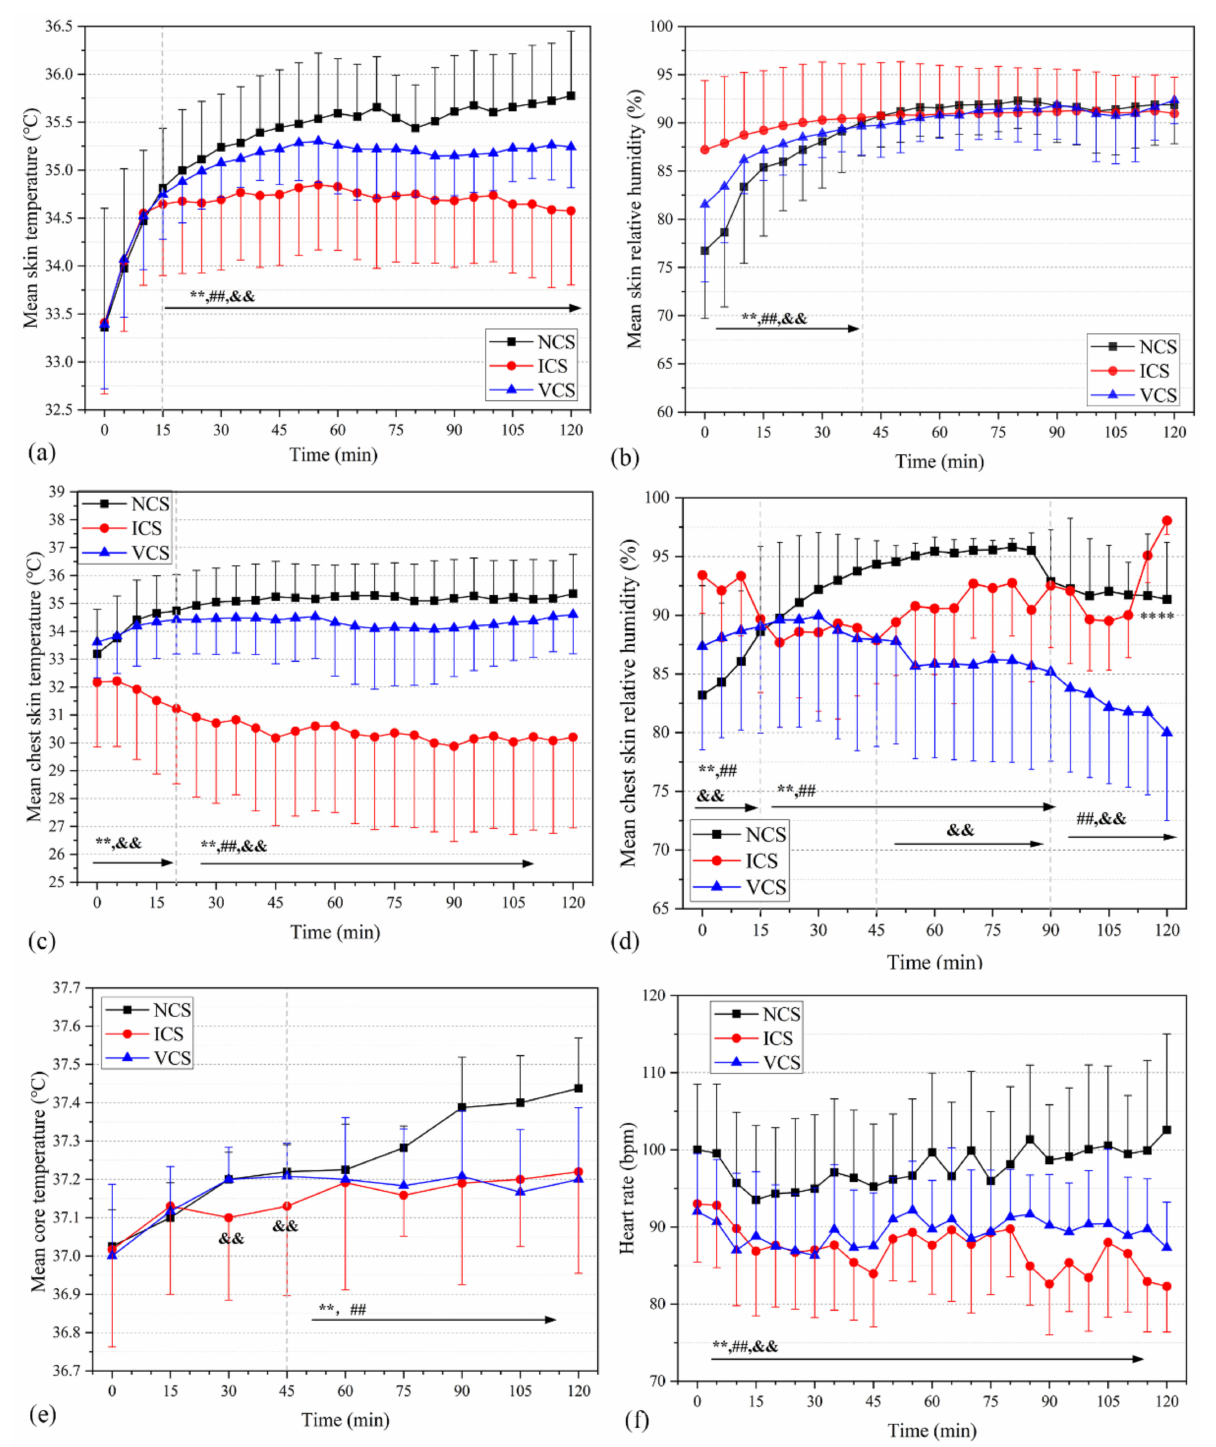
Figure 9. Temporal variations in physiological parameters in NCS, ICS, and VCS. ( a ) Mean skin temperature. ( b ) Mean skin relative humidity. ( c ) Mean chest skin temperature. ( d ) Mean chest skin relative humidity. ( e ) Mean core temperature. ( f ) Mean heart rate. **, p < 0.001 (NCS vs. ICS); ##, p < 0.001 (NCS vs. VCS); &&, p < 0.001 (ICS vs.